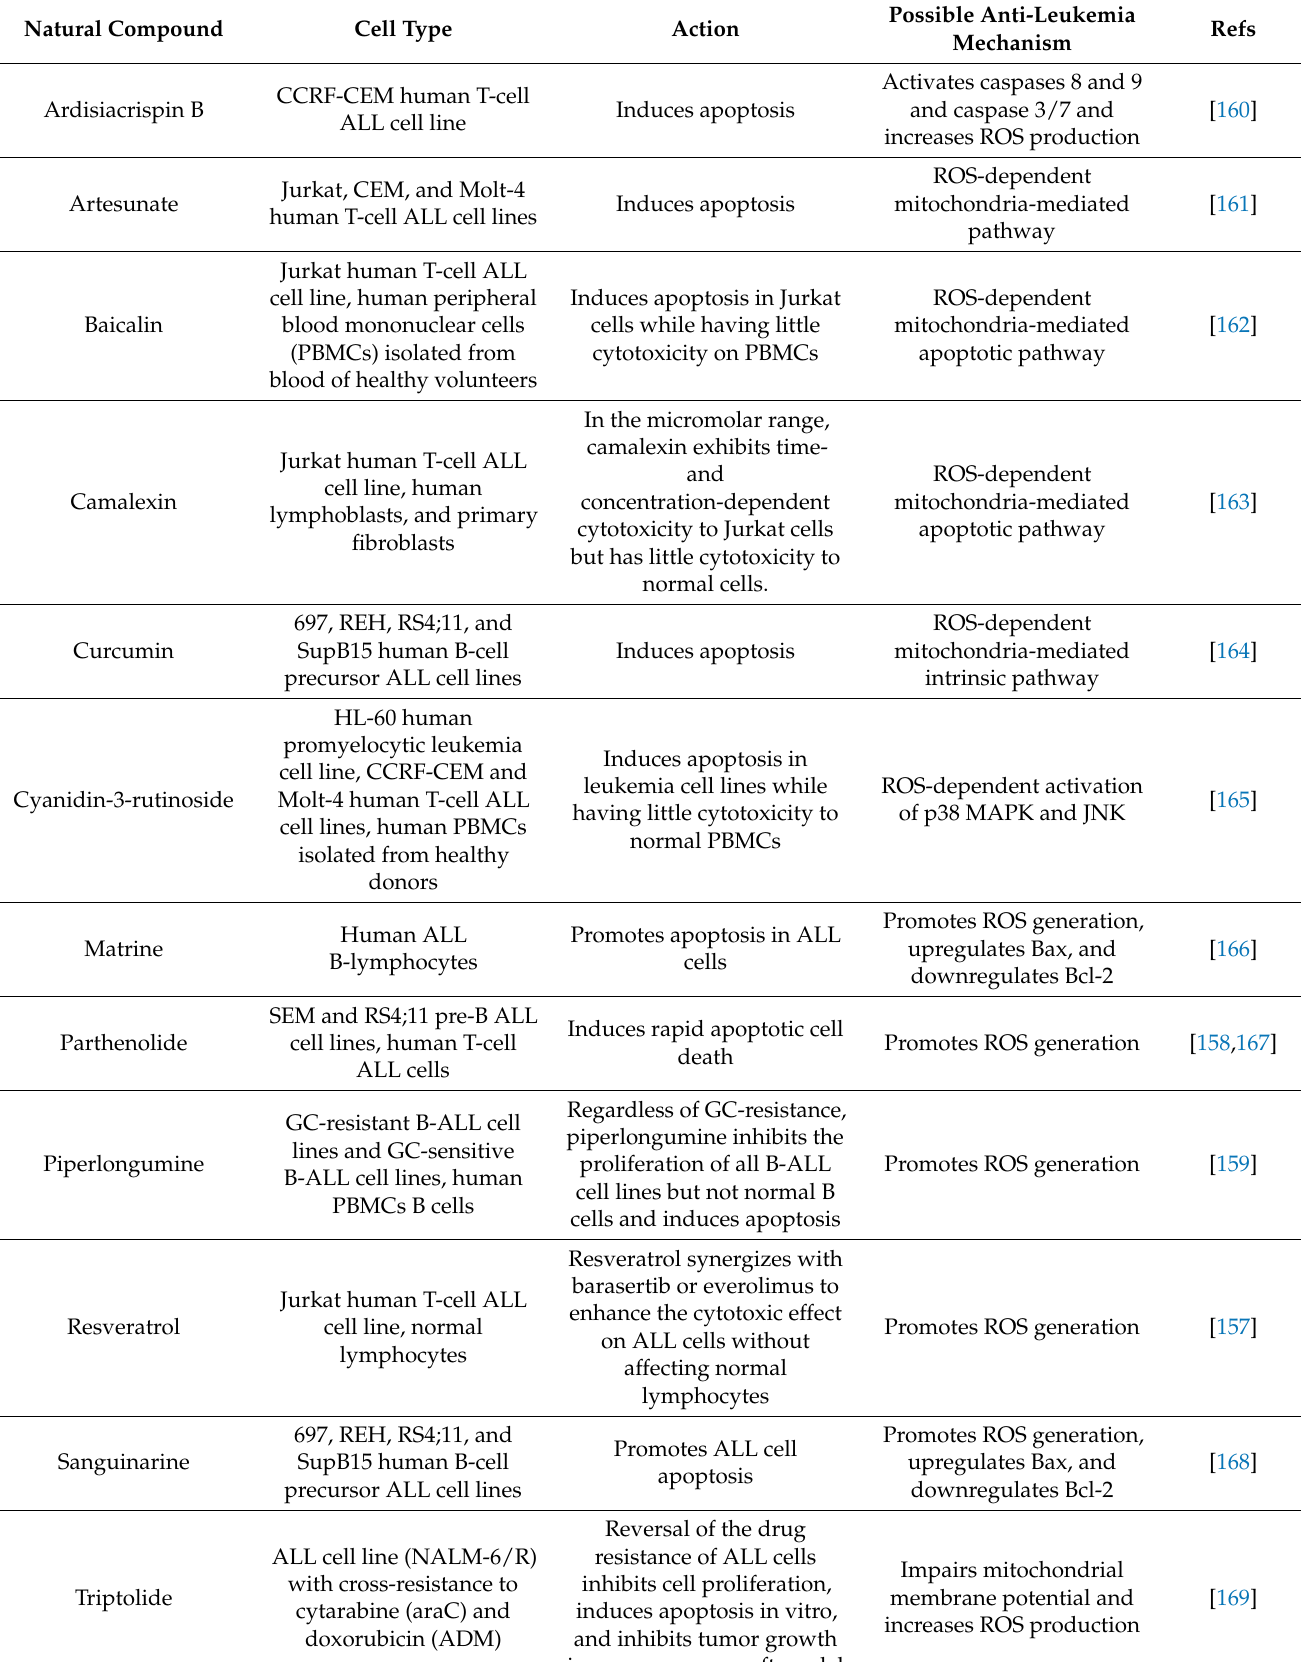
Table 3. Natural compounds that exert anti-ALL effects through